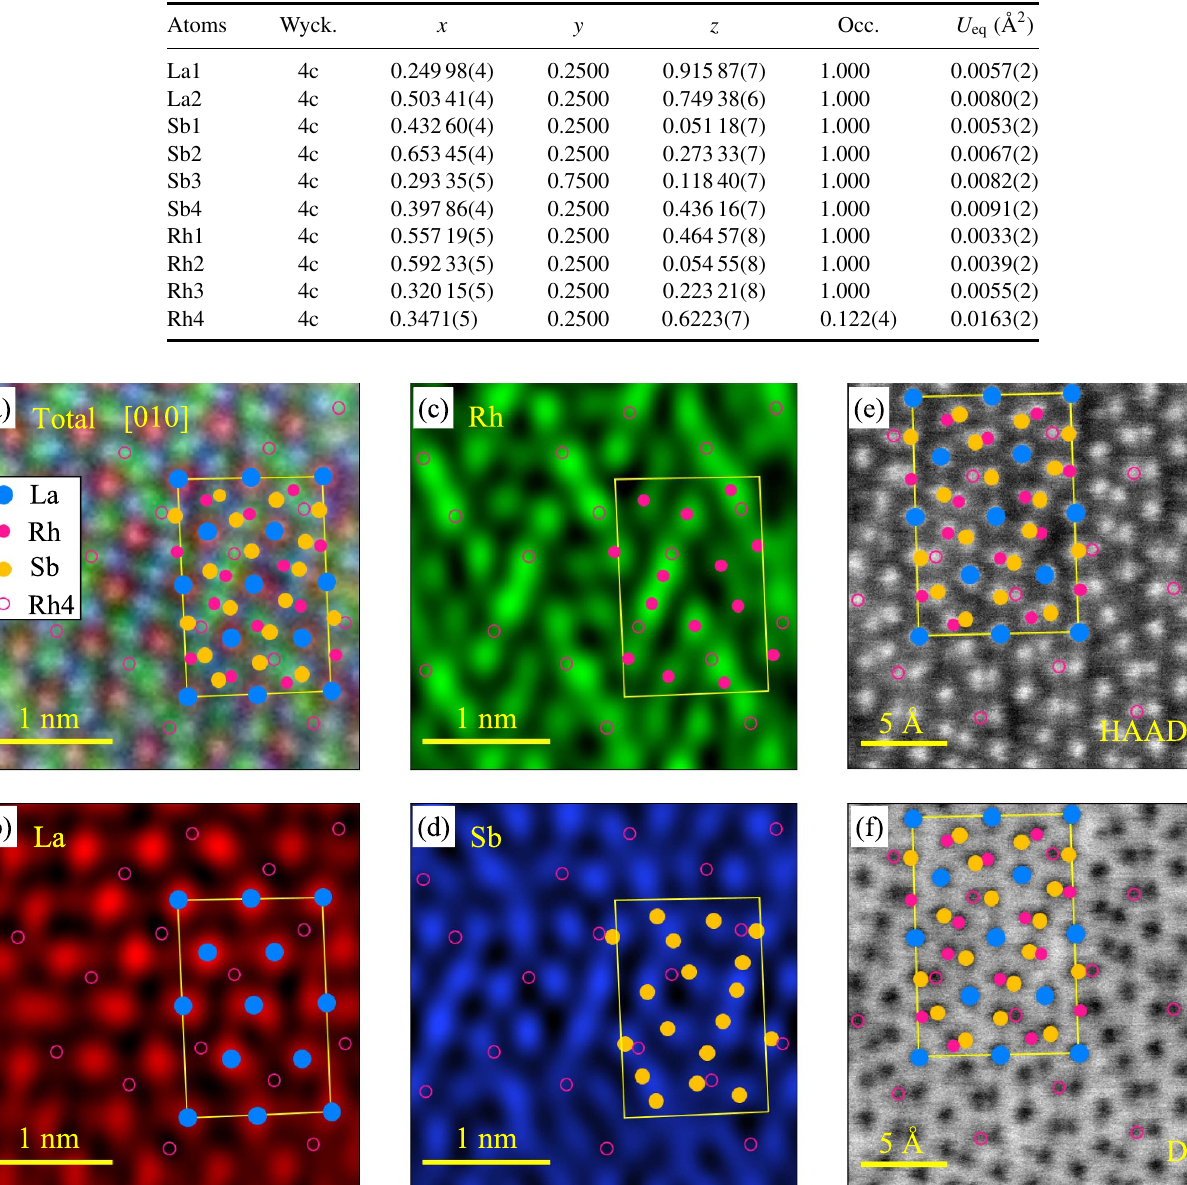
Table 2. Structural parameters and equivalent isotropic displacement parameters U eq of La 2 Rh 3 + δ Sb 4 . U eq is taken as 1/3 of the trace of the orthogonalized U ij tensor.